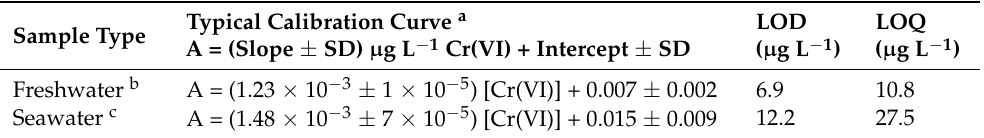
Table 2. Features of the developed flow-based system for Cr(VI) quantification in fresh and sea- water; dynamic range, 25 to 200 µ g L − 1 ; LOD, limit of detection; LOQ, limit of quantification; SD, standard